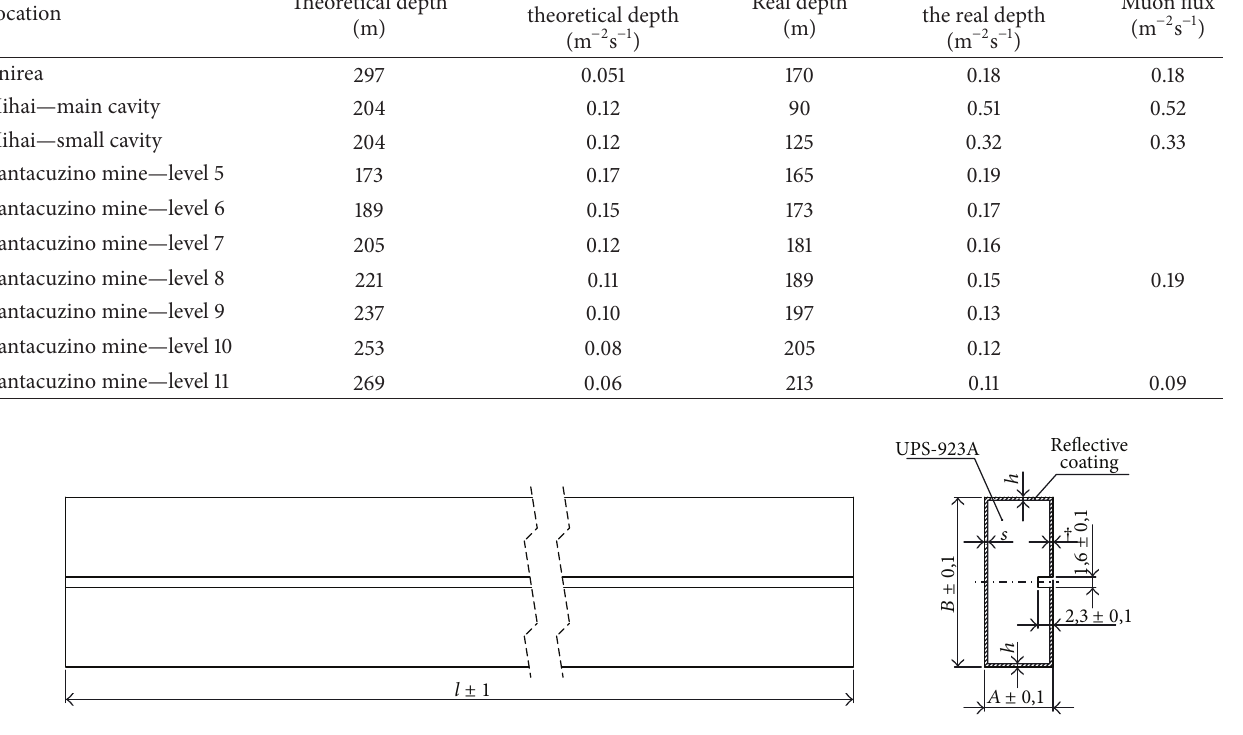
Figure 2: The scintillator bar